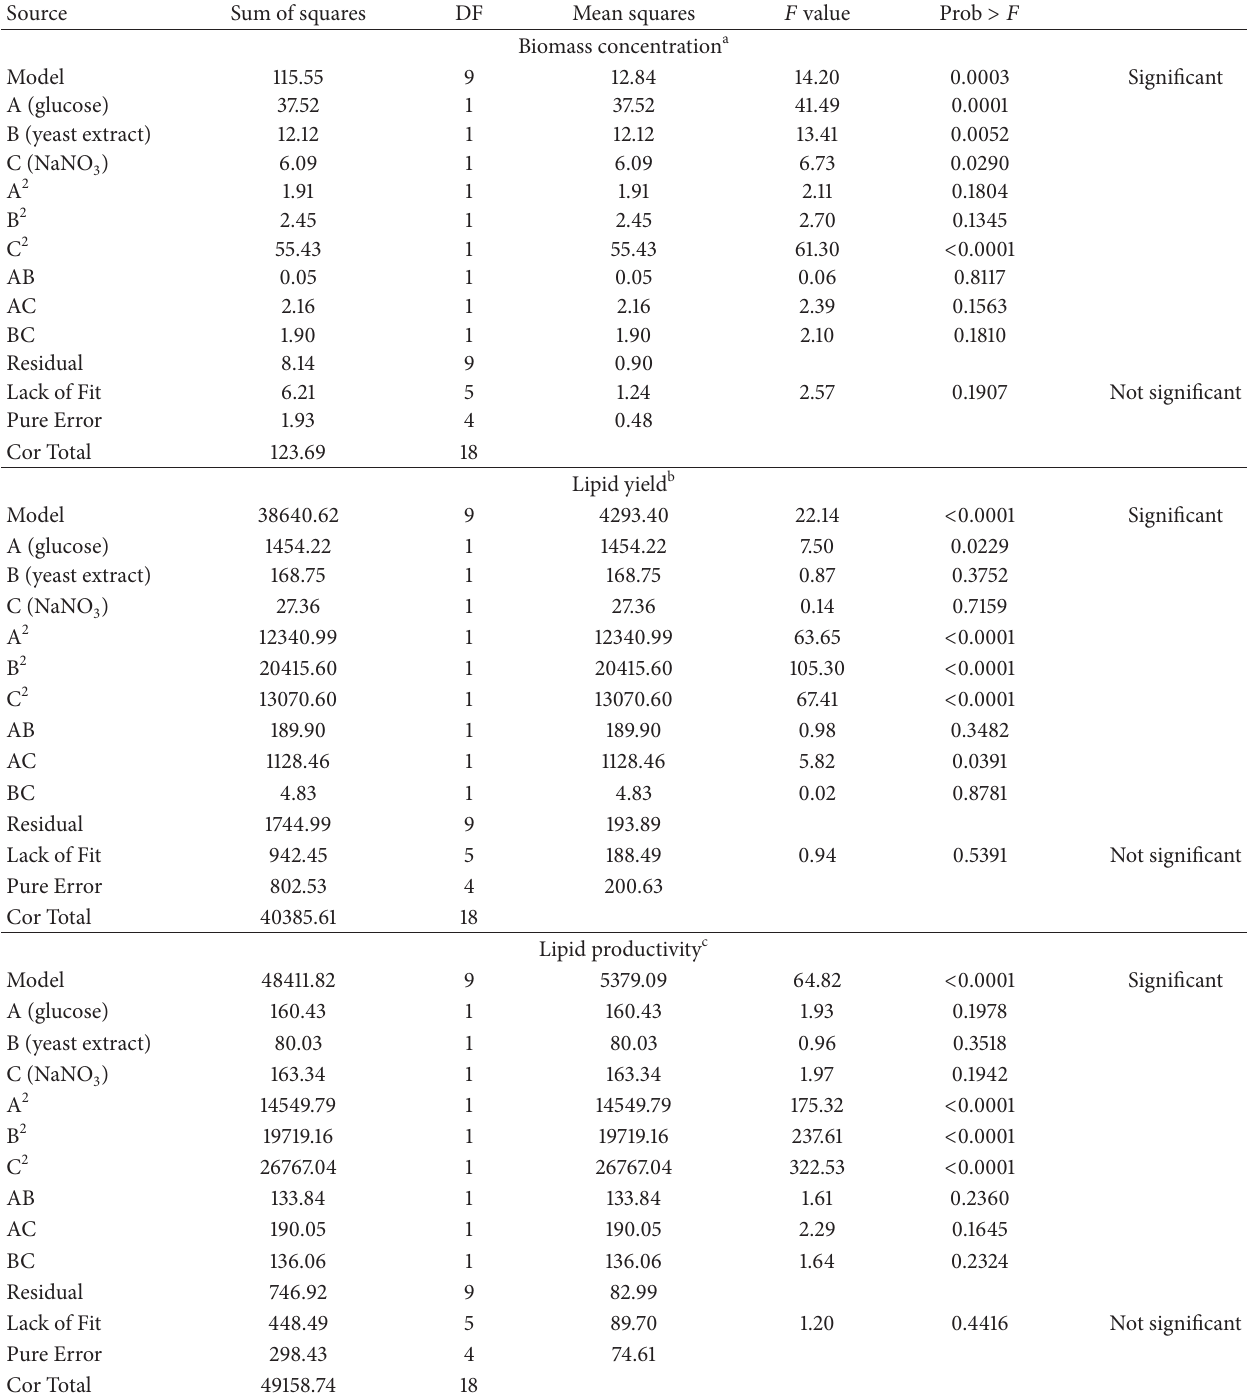
Table 3: ANOVA tables showing the regression model on a biomass concentration, b lipid yield, and c lipid productivity.